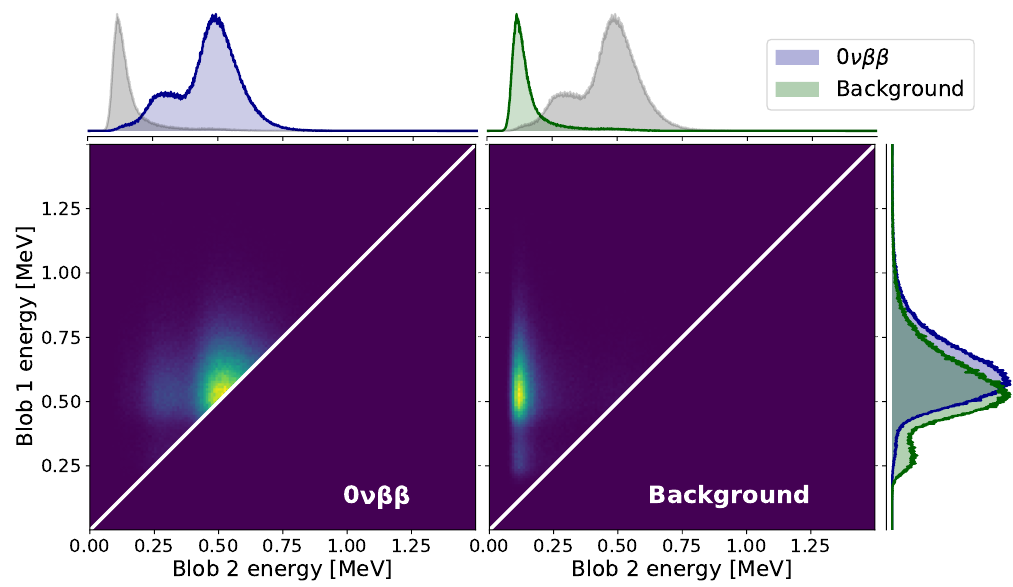
Figure 7 . Blob energies of signal and background events. The blobs are defined such that blob 1 always has higher